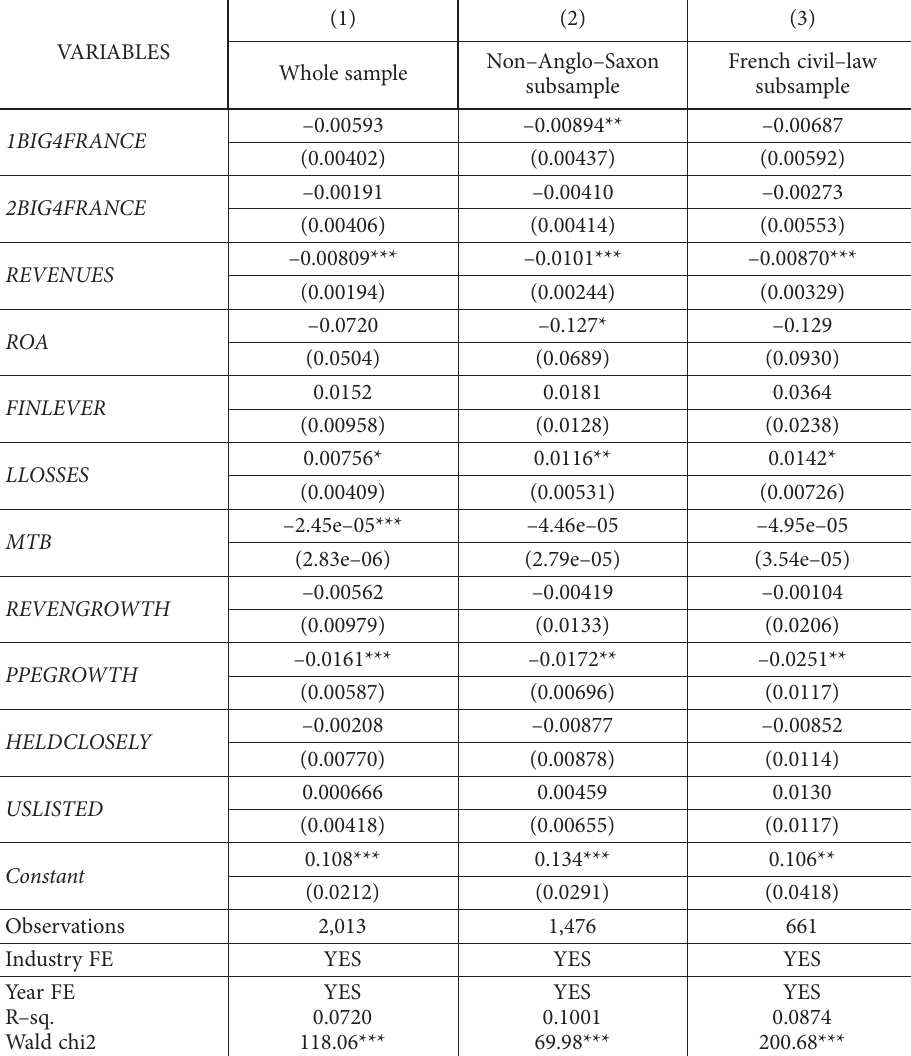
Table 5. The relationship between joint audits and discretionary accruals by audit firm type. Dependent variable: